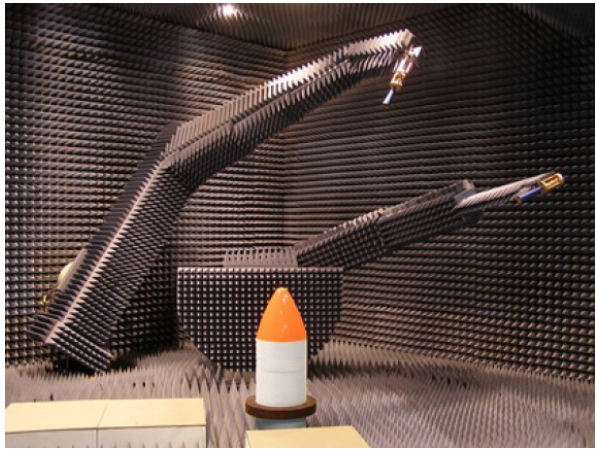
Figure 11. BIANCHA (Bistatic ANechoic CHAmber).